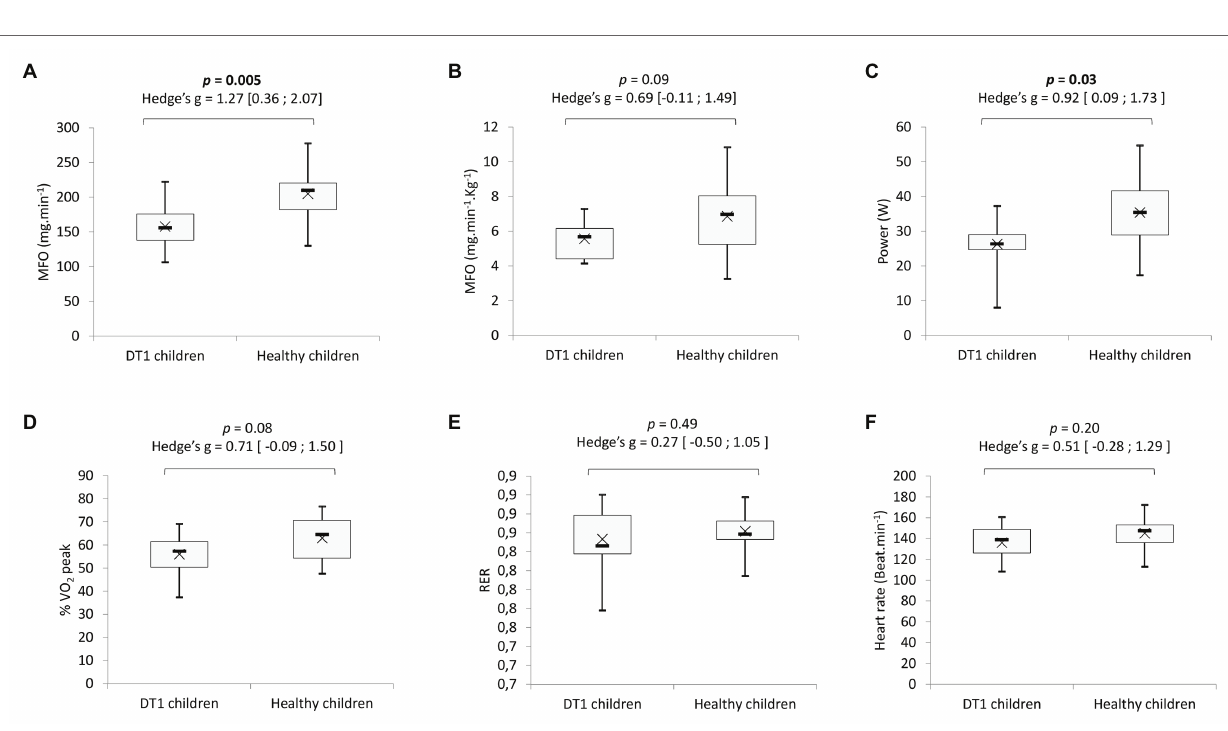
FIGURE 3 | Comparison of absolute (A) and relative (B) maximal fat oxidation rate (MFO). Power (C) , percentage of VO 2 peak (D) , respiratory exchange ratio (E) , and heart rate (F) at the MFO. Boxes represent interquartile ranges. Whiskers give minimum and maximum values. Data are mean (x) and median ( −